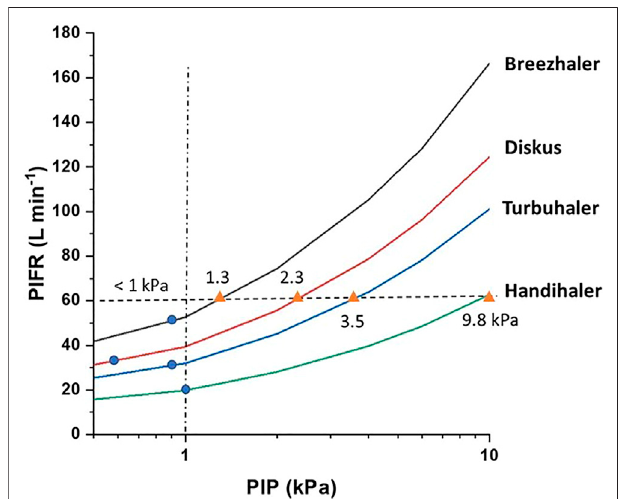
FIGURE 1 | Plot of the PIFR versus PIP for four portable dry powder inhalers with varying device resistance. The circles on each curve represent the minimum PIP or PIFR for effective drug delivery based on the data presented herein. The triangles represent the corresponding PIP values for individual inhalers at a PIFR of 60 L min − 1